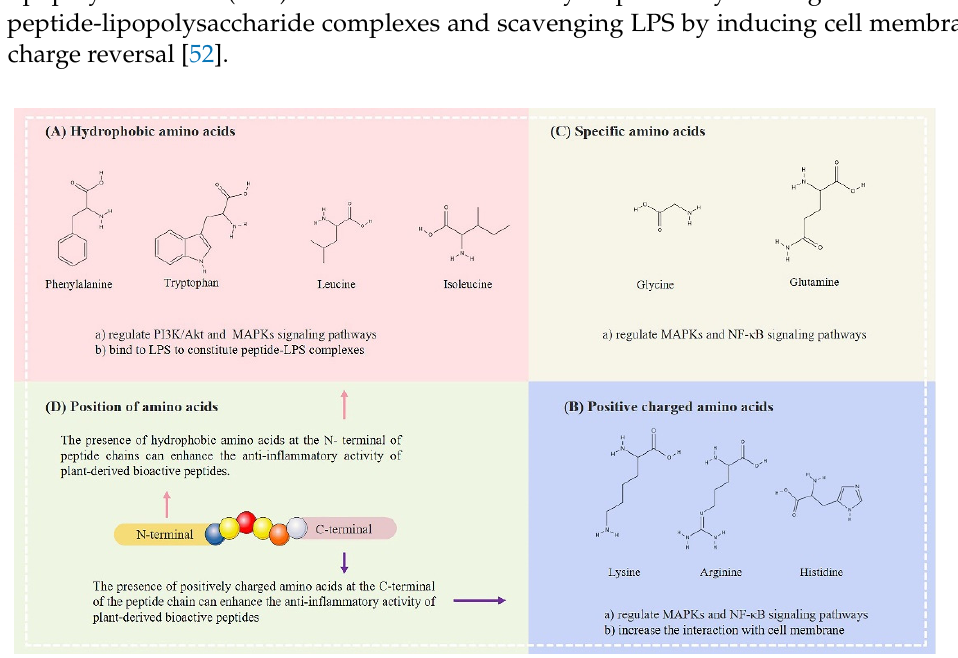
Figure 3. Effects of amino acid composition and position on the anti-inflammatory activity of low- molecular-weight bioactive peptides.